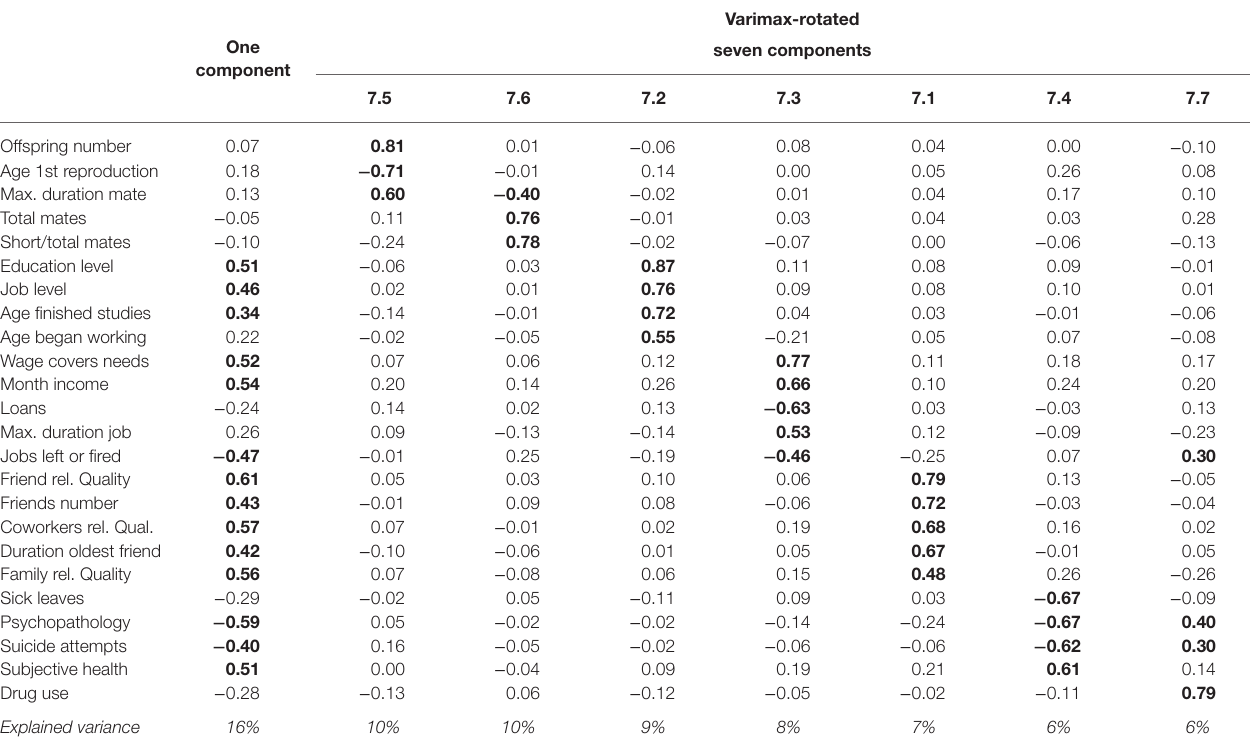
TABLE 3 | One-component and varimax-rotated seven-component solutions for reproductive and somatic LH traits.